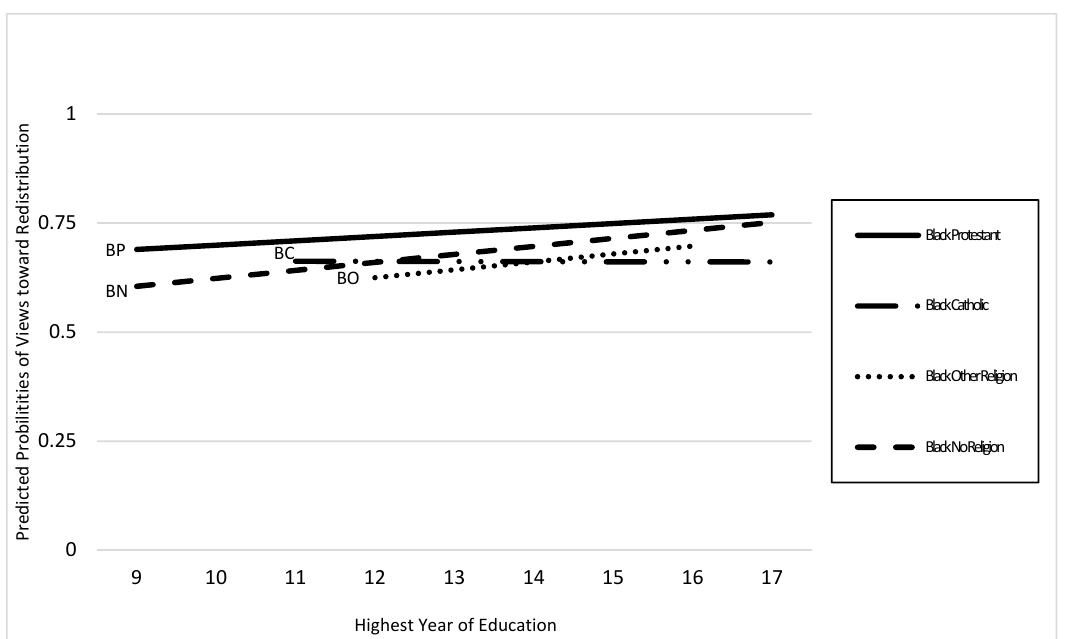
Figure 6. The interaction of religion and education on views toward redistribution.